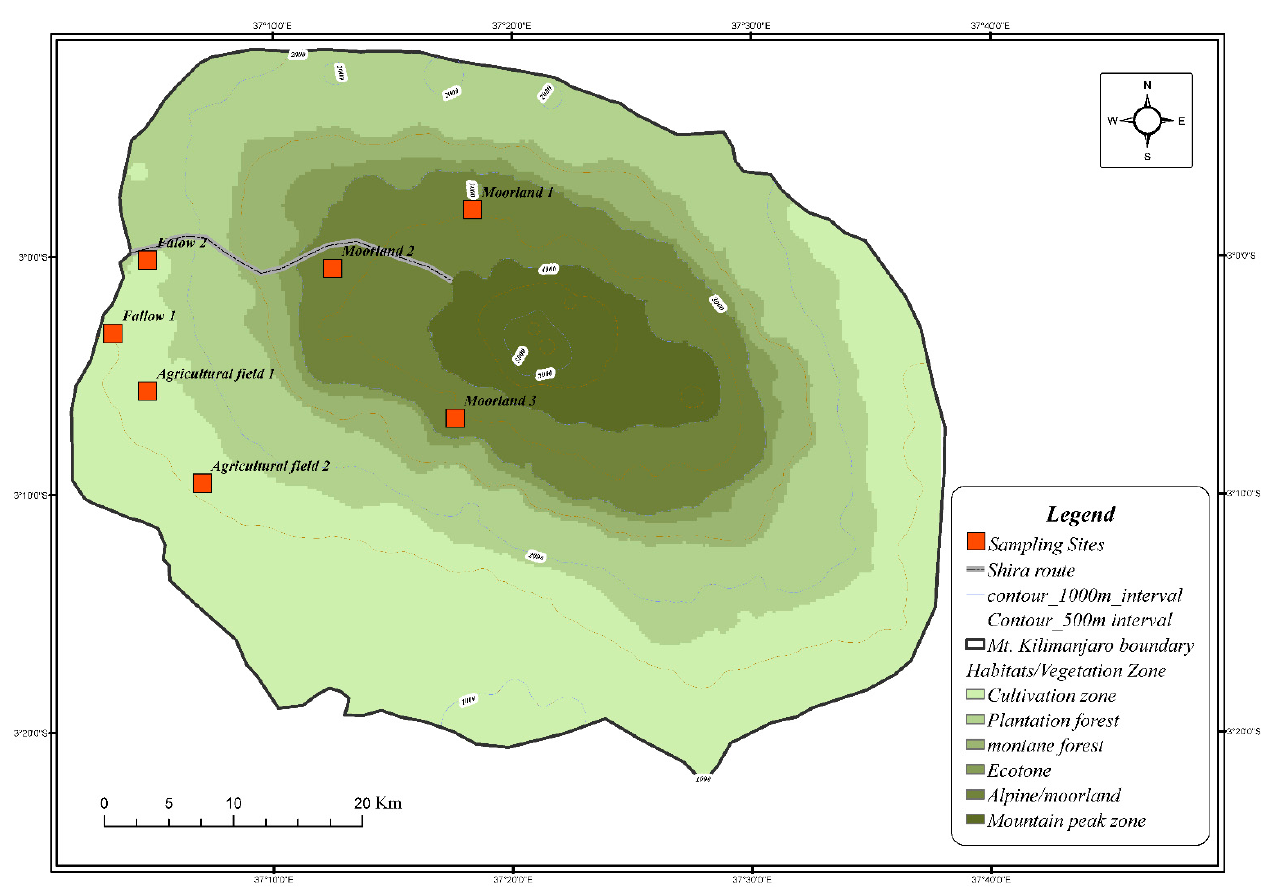
Figure 1. A map of Mount Kilimanjaro showing study sites in the selected three habitats along the Shira route.